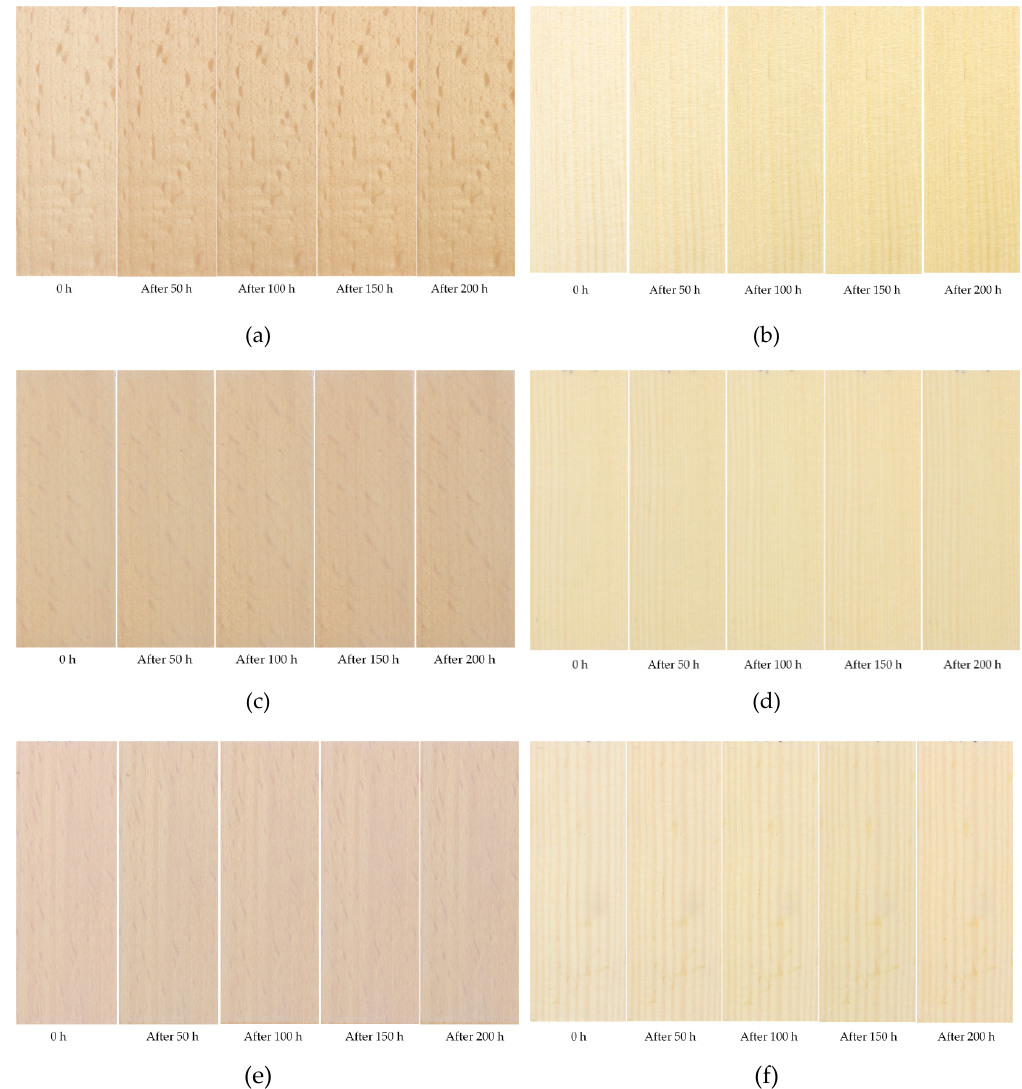
Figure 7. Visual appearance of coated and uncoated samples, before and after 50, 100, 150, and 200 h of UV- irradiation: ( a ) control beech wood; ( b ) control pine wood; ( c ) beech wood coated with polyester/TiO 2 thick film; ( d ) pine wood coated with polyester/TiO 2 thick film; ( e ) beech wood coated with polyester/TiO 2 film via (PSP); ( f ) pine wood coated with polyester/TiO 2 film via (PSP).